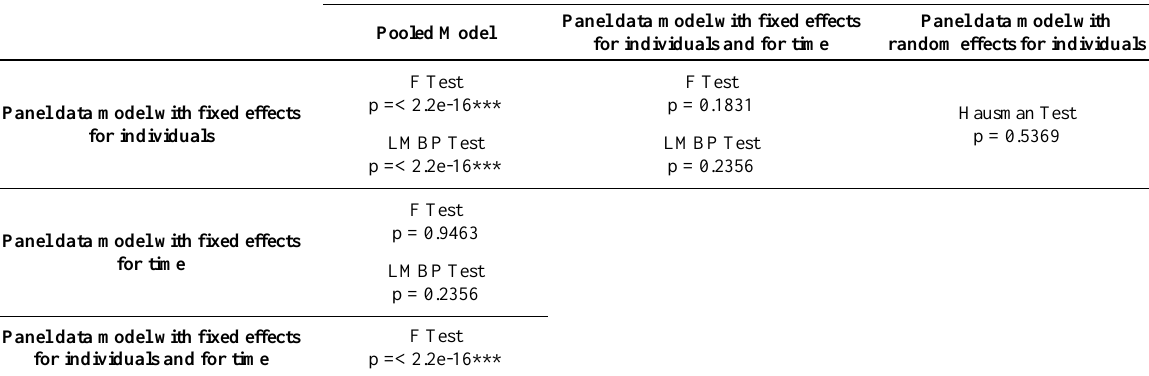
Table 5. Tests to select the most adequate model.